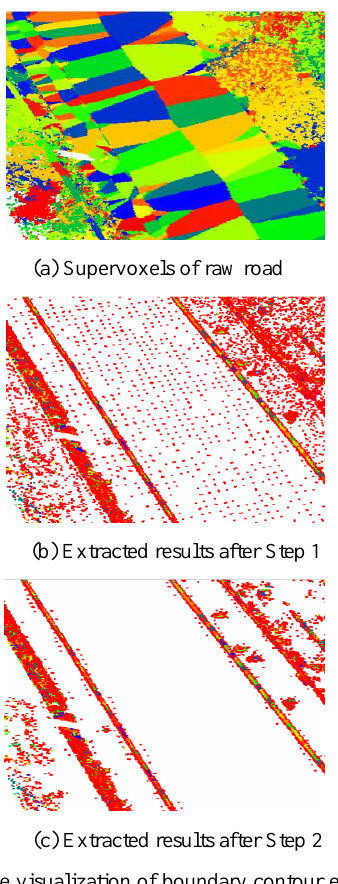
Figure 10. The visualization of boundary contour extraction. (a) Our supervoxel with resolution of supervoxel is 3. (b) The boundary contour after step 1. (c) The boundary contour after step 2 empirically. We show several close-ups of outlier regions for comparison